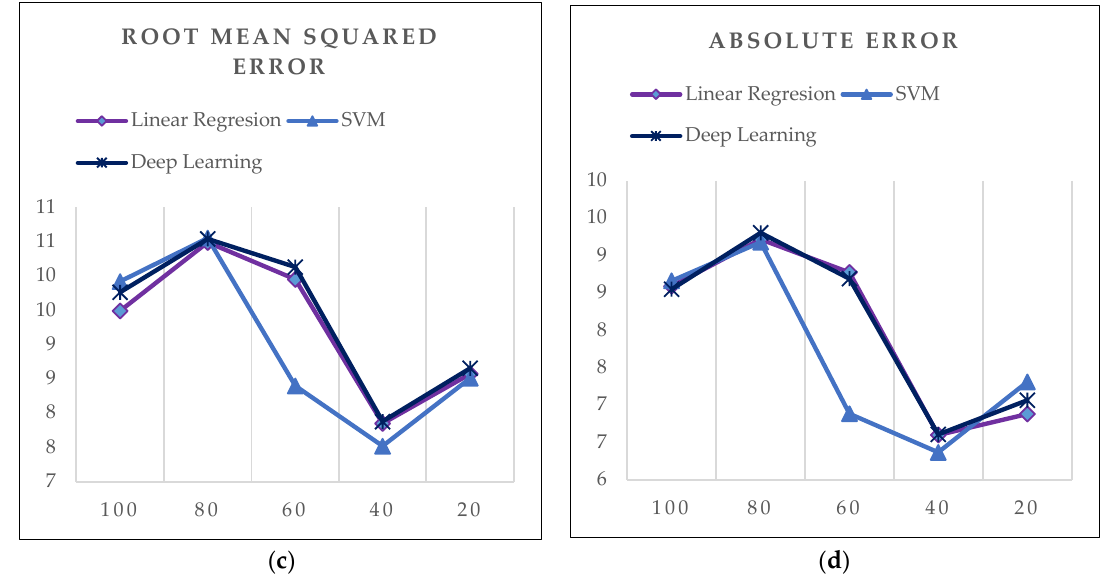
Figure 12. Results graph: ( a ) (RMSE) vehicle speed before segment, ( b ) ( AE ) vehicle speed before segment, ( c ) RMSE vehicle speed after segment, ( d ) AE vehicle speed after segment.